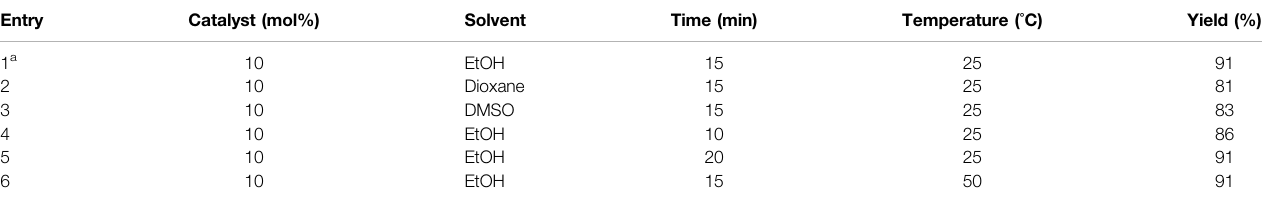
TABLE 4 | Optimization of the reaction conditions (solvent, reaction time, and temperature) for the synthesis of compound 11a